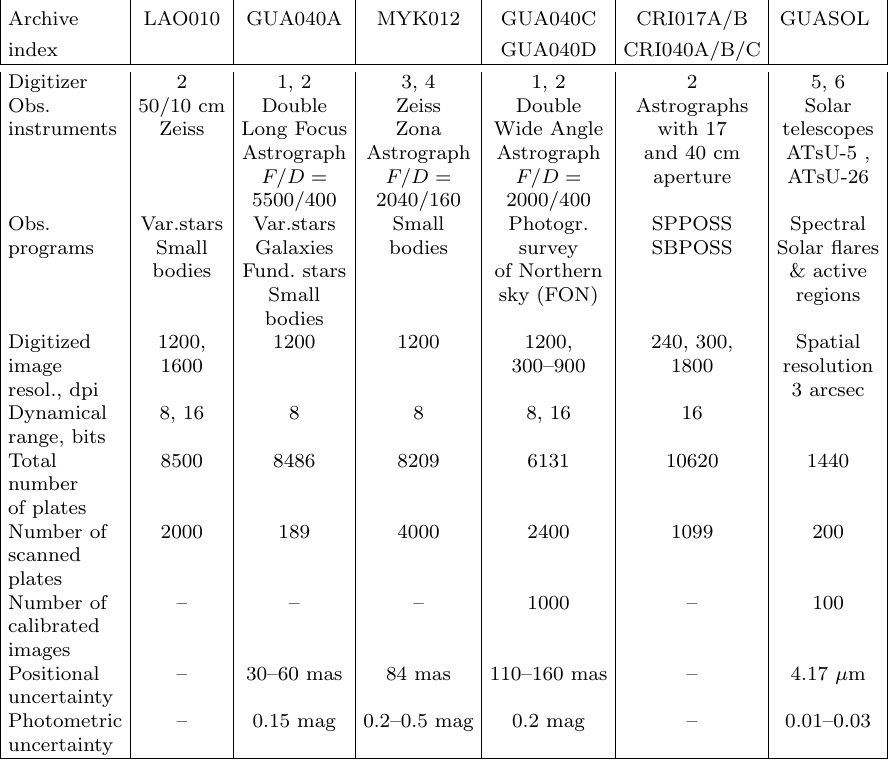
Table 1. UkrVO largest digitized